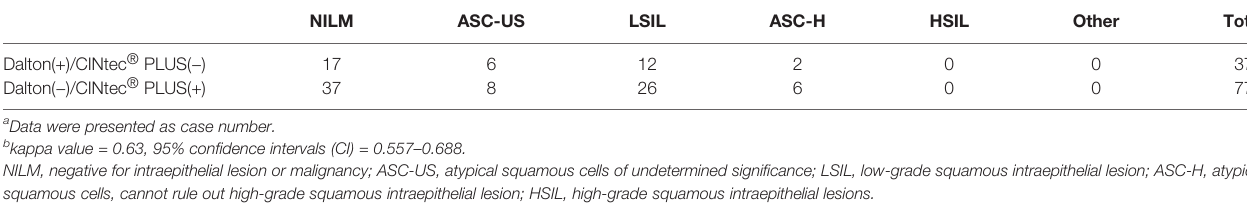
TABLE 4 | Ef fi cacy of Dalton and CINtec ® PLUS p16/Ki-67 Dual Stain to identify CIN3+ and CIN2+ among 717 HPV-positive women. Test Detection of CIN3+ (n = 37) Sensitivity